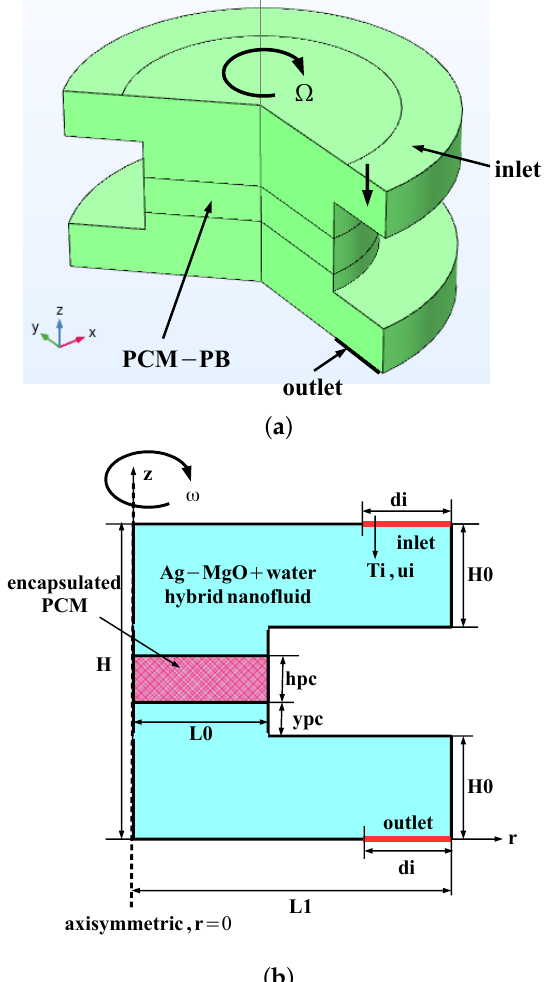
Figure 1. 3D view of the complex geometry of the vented cavity with one inlet and outlet port, as well as the ( a ) boundary conditions and schematic view in 2D ( b